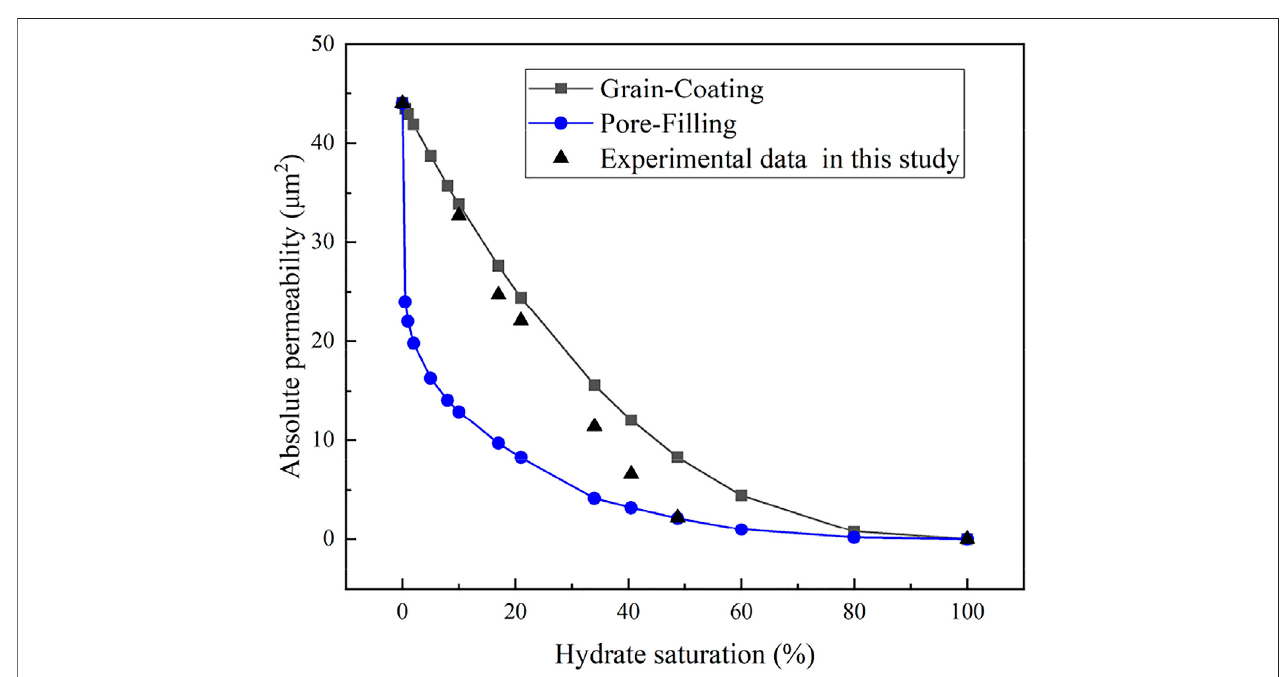
FIGURE 6 | Absolute permeability variation with hydrate saturation from experimental data and permeability models.